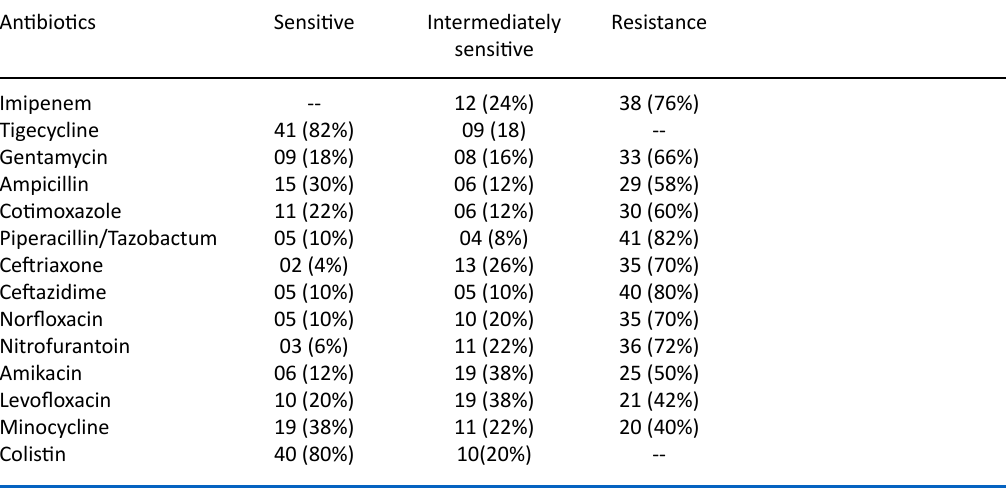
Table 4. Antibiotic sensitivity pattern of MDR Acinetobacter isolates to different antibiotics Antibiotics Sensitive Intermediately Resistance sensitive